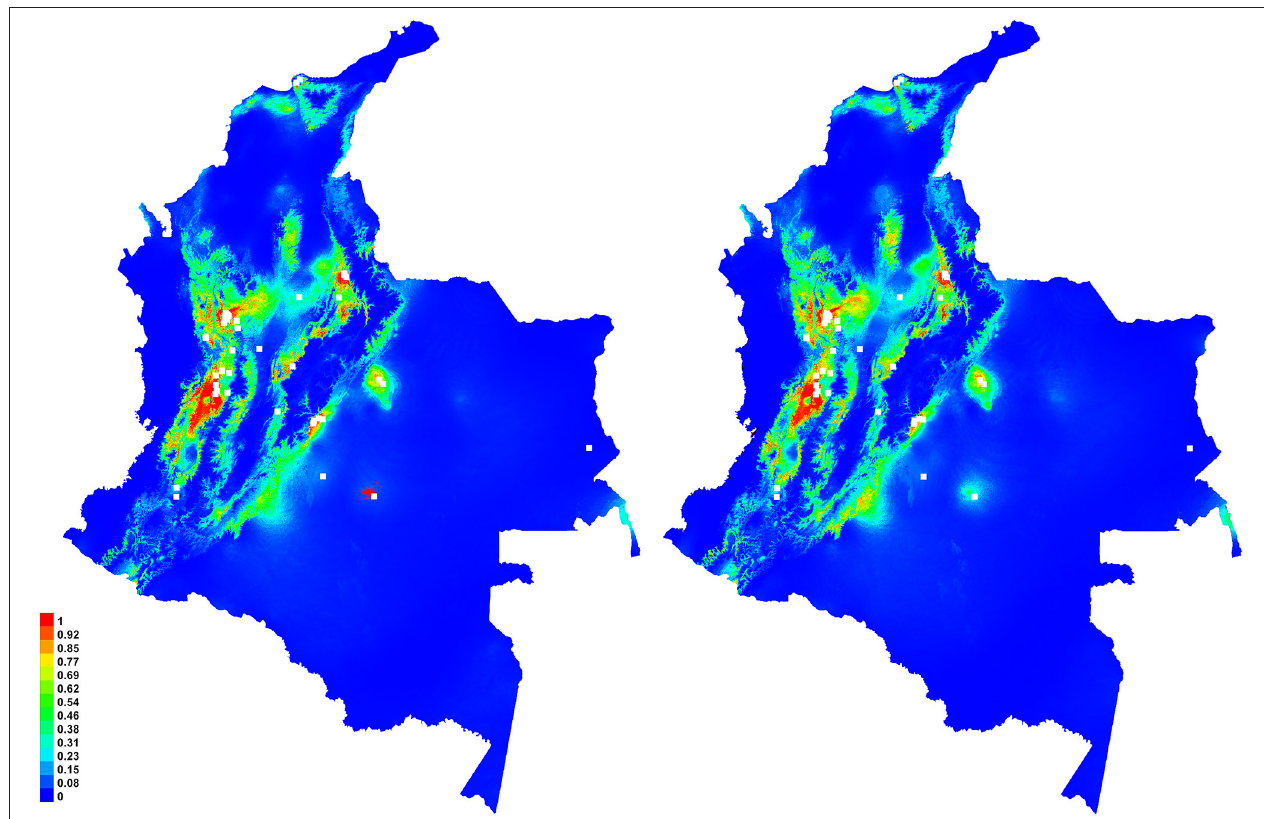
FIGURE 7 | NPV probability distribution for the grass-legume association and the grass monoculture under climate change scenarios. GLA, Grass-legume association; GM, Grass